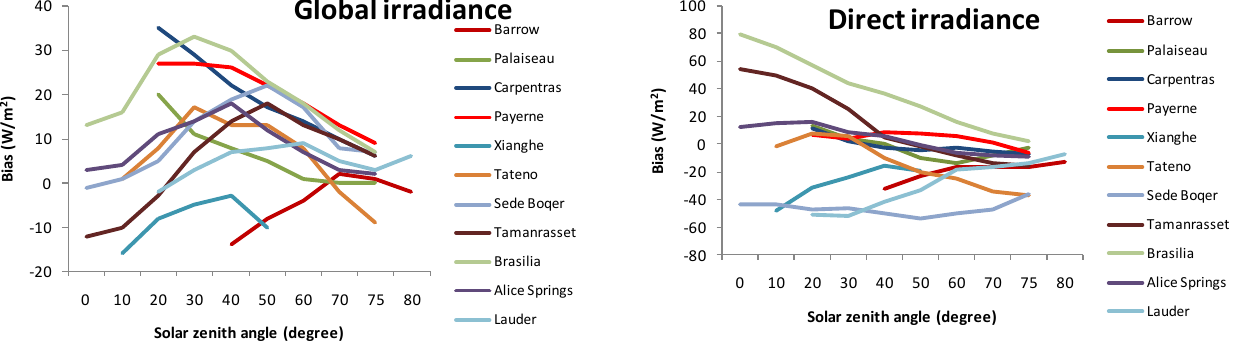
Fig. 14. Change in bias as a function of the solar zenith angle for all stations. Direct irradiance.